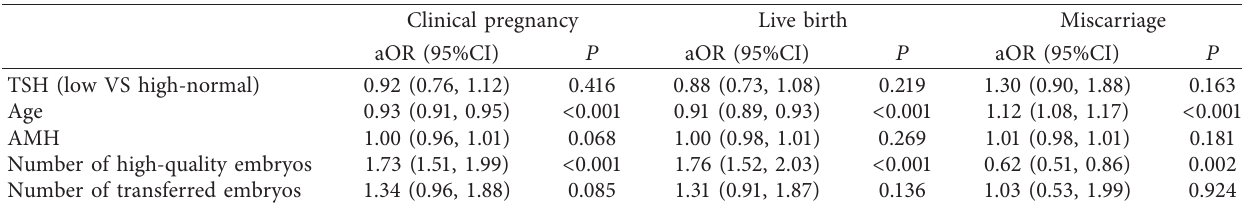
Table 3: The possible factors that impact on clinical outcomes. Clinical pregnancy Live